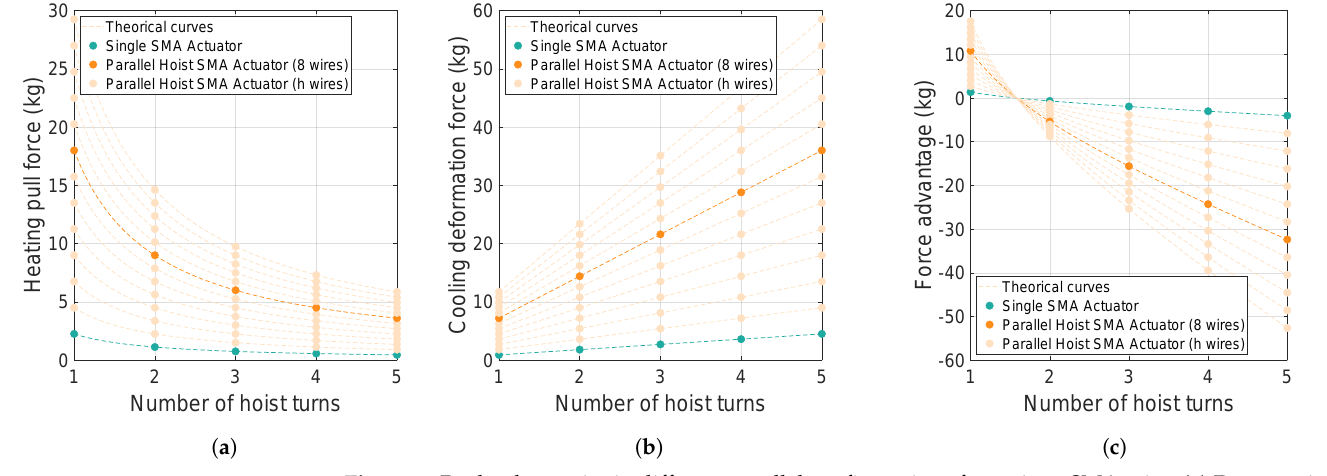
Figure 4. Payload capacity in different parallel configurations for a given SMA wire. ( a ) Decrease in the pulling force. ( b ) Increase in the deformation force. ( c ) Force